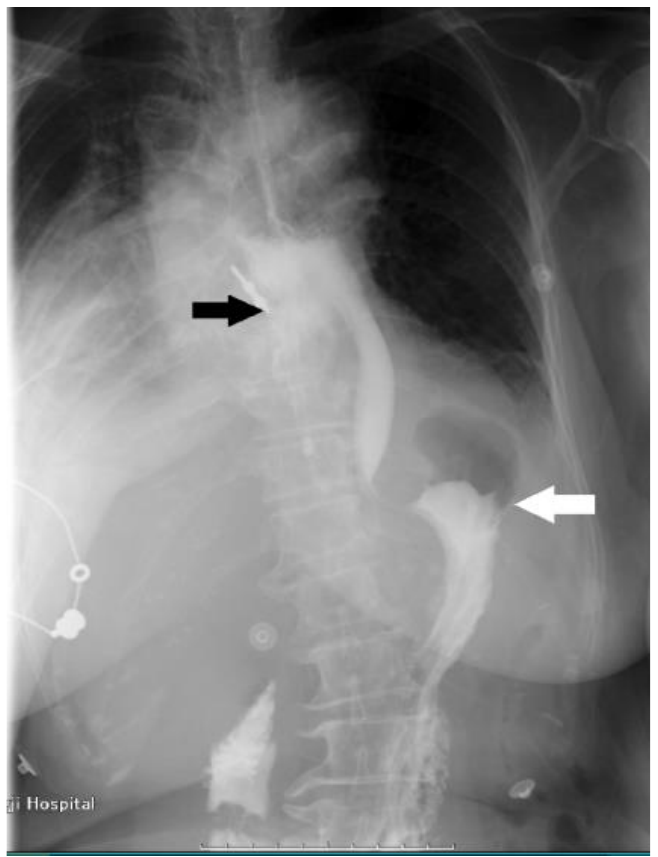
Figure 2. The esophagography shows leakage of contrast medium (white arrow), barium meal leakage, and esophageal diverticulum on the right side of the esophagus (black arrow).